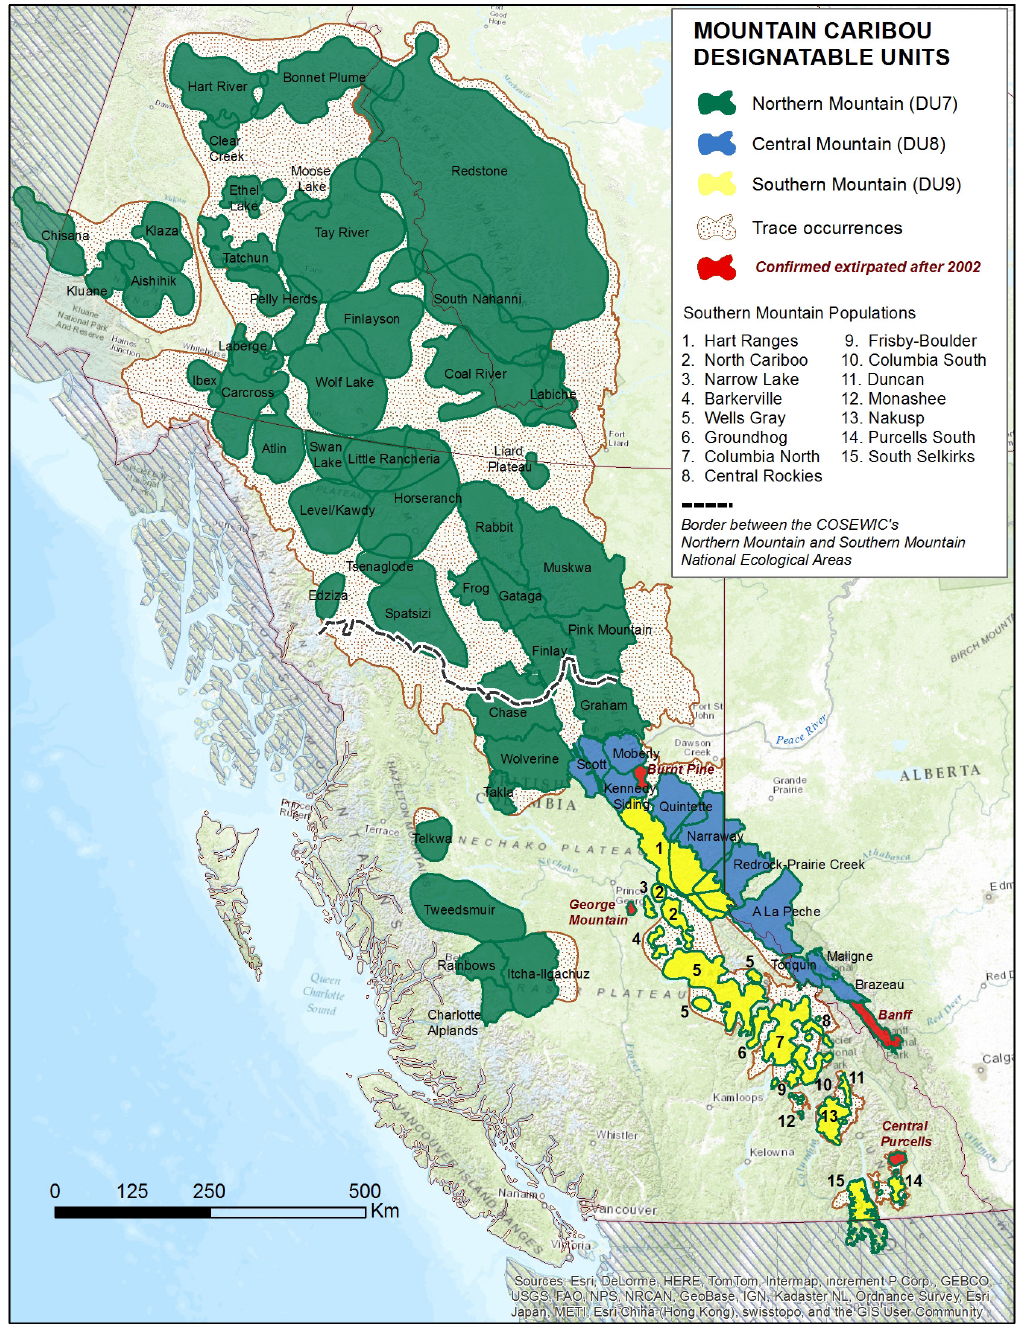
Figure 2. Caribou subpopulations in the Northern Mountain DU, Central Mountain DU, and Southern Mountain DU. The border between COSEWIC's Northern and Southern Mountain National Ecological Areas depicts the COSEWIC (2002) Northern and Southern Mountain Population boundaries (from COSEWIC 2014a). Map cre- ated by Bonnie Fournier (Environment and Natural Resources, Government of the Northwest Territories,